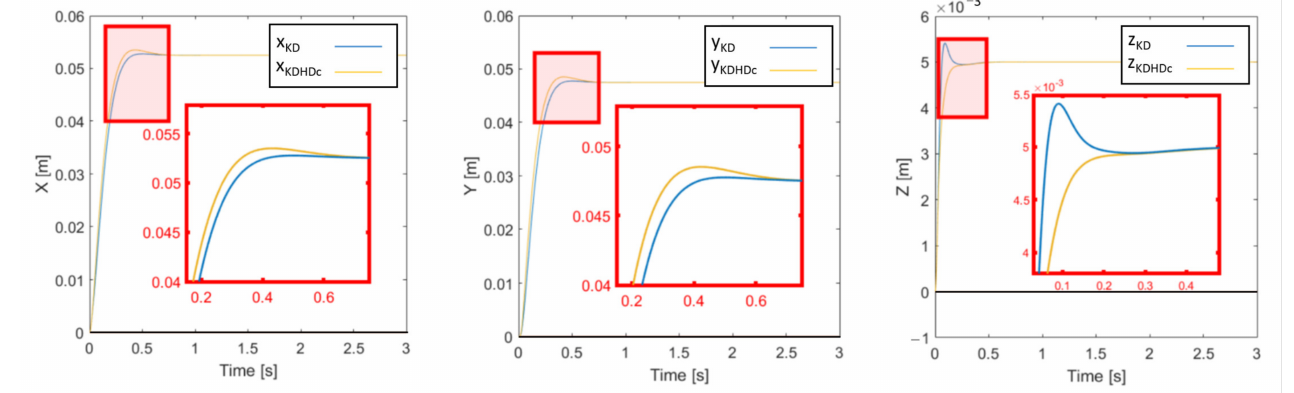
Figure 10. Case study C, KD-KDHD comparison number II, external coordinates.